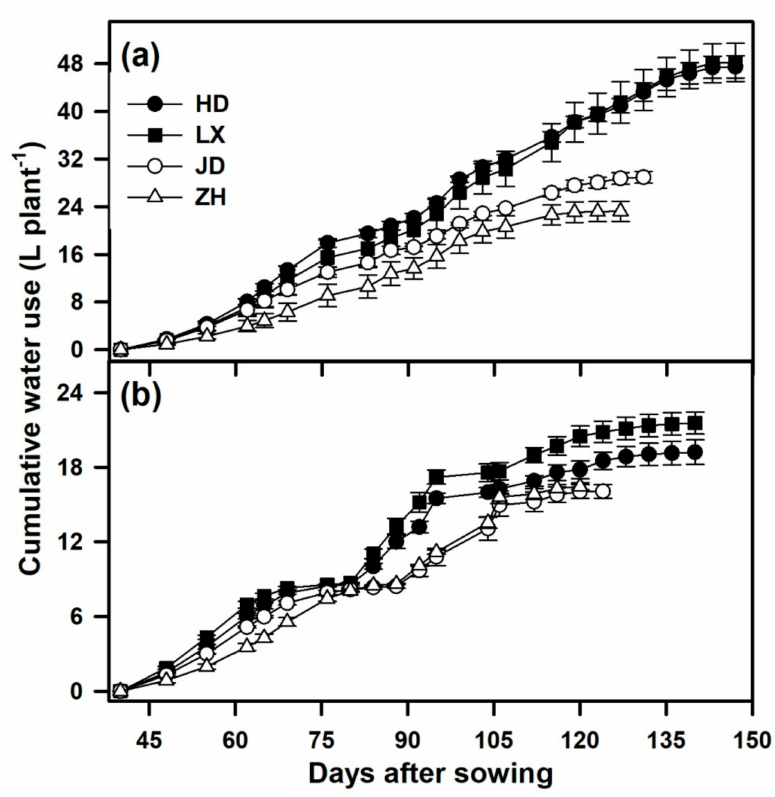
Figure 5. Cumulative water use with time in four soybean genotypes (two landraces: Huangsedadou (HD), Longxixiaohuangpi (LX), and two recent cultivars: Jindou 19 (JD) and Zhonghuang (ZH)) when ( a ) well-watered (WW) and ( b ) with cyclical water stress (WS) imposed from 40 days after sowing in the pot experiment in 2014. Note the di ff erences in the y -axes of ( a , b ). The bars indicate one standard error of the mean ( n =